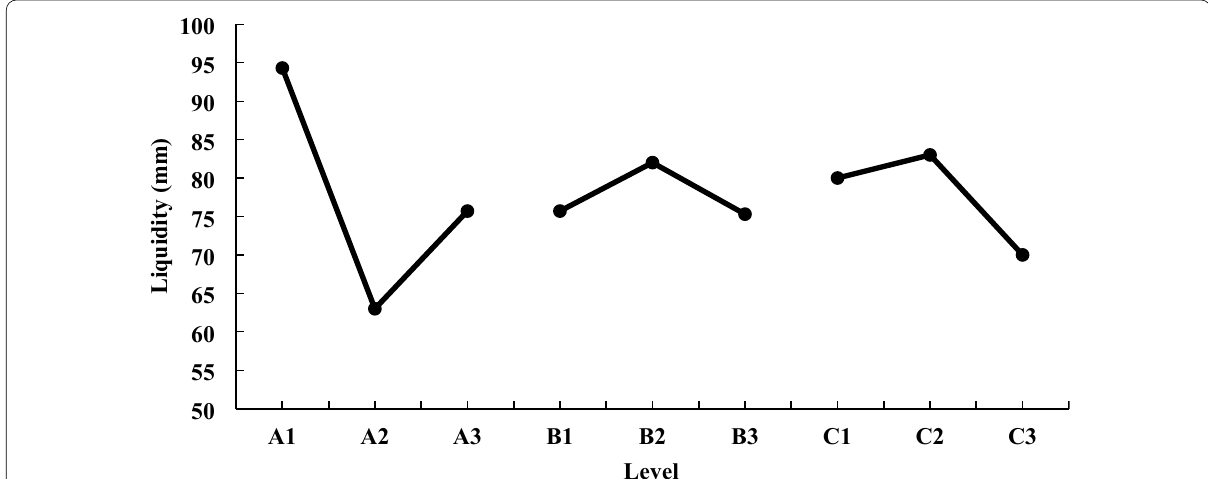
Fig. 3 Relationship between the cement mortar mobility and the mixing volume of various factors.